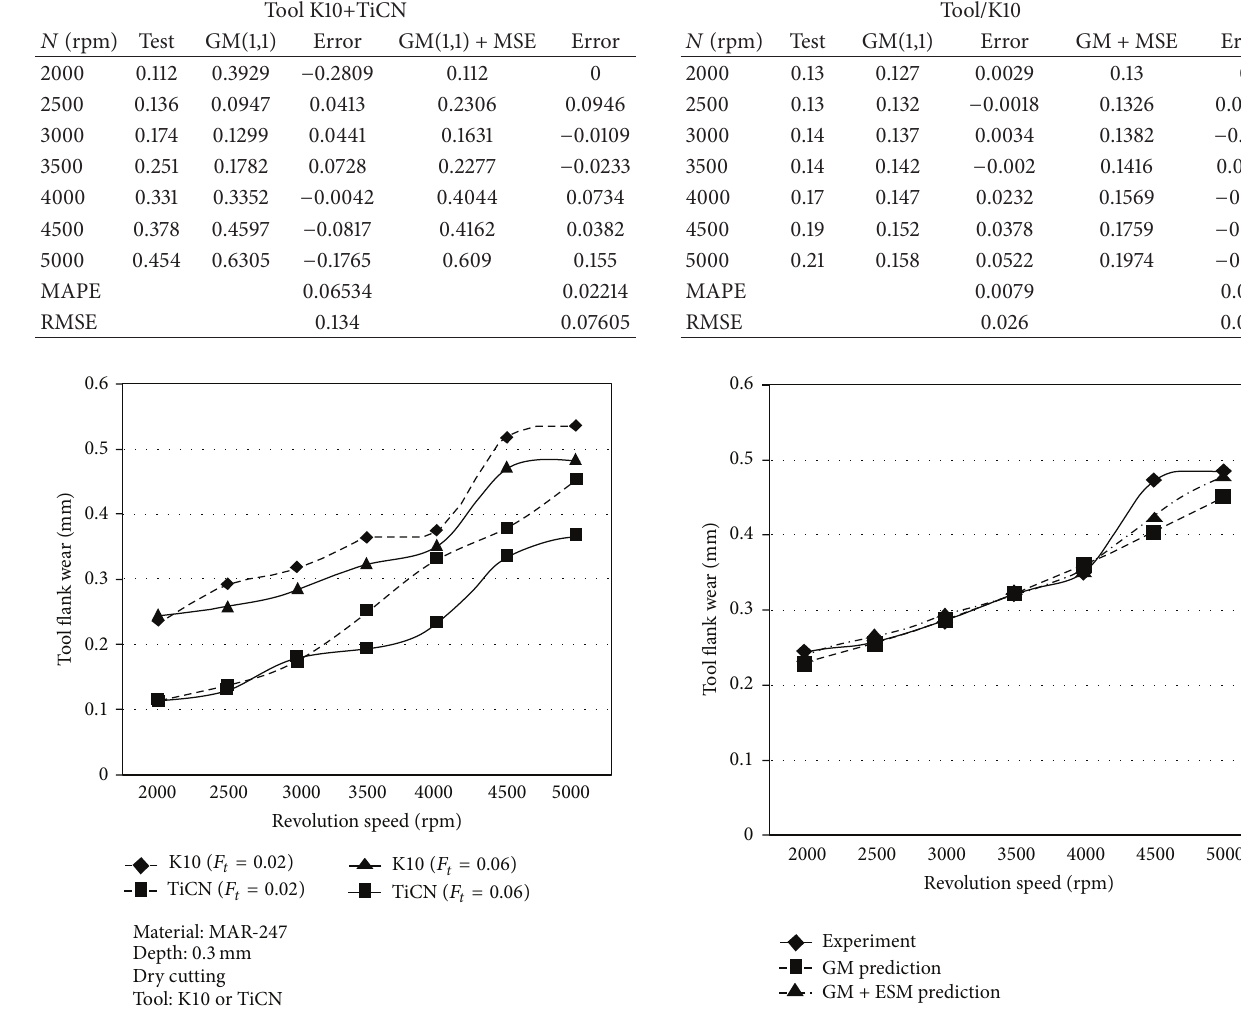
Figure 8: Relationships between revolution speed of main shaft and tool wear prediction.